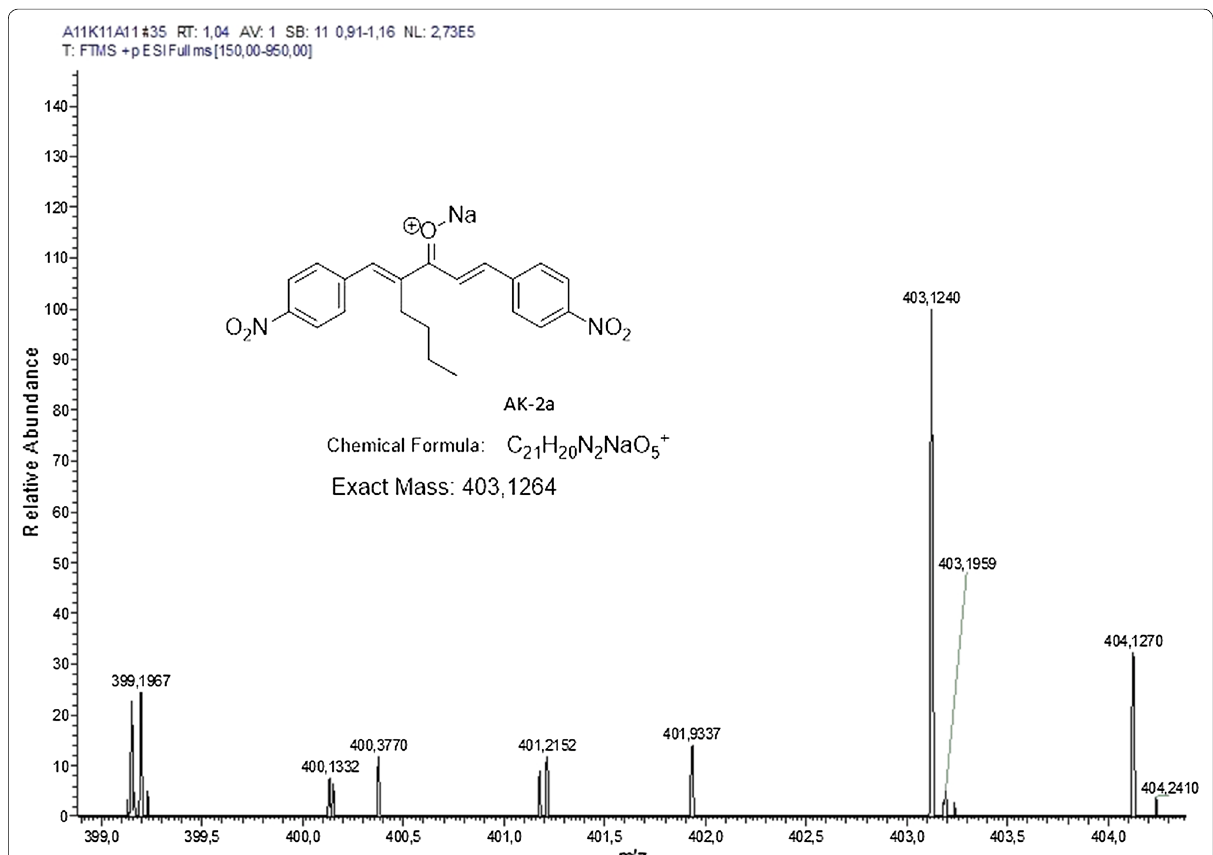
Fig. 3 Represents Fourier transform mass spectrometry (FTMS) of (1E,4 E )‑4‑(4‑nitrobenzylidene)‑1‑(4‑nitrophenyl)oct‑1‑en‑3‑one